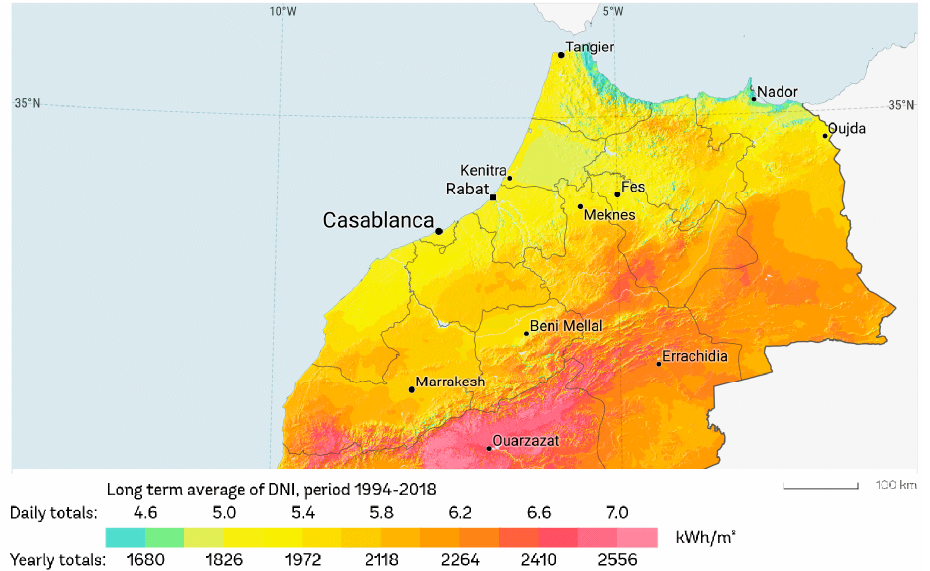
Figure 1. Locations on a map of Morocco of both outdoor sites used for exposure tests. Maroc (SolarGis.info).